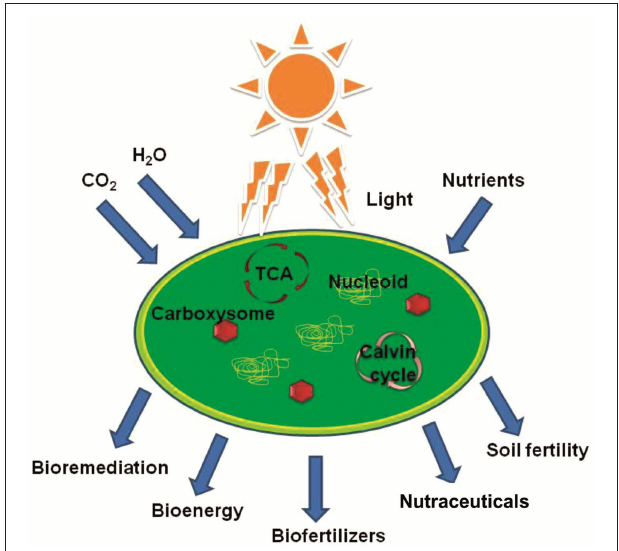
FIGURE 1 | Various outcomes of cyanobacterial growth that can be utilized for the development of sustainable agricultural